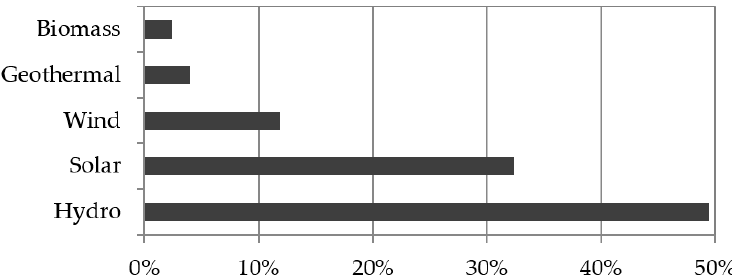
Figure 9. Breakdown of answers to the question “Which renewable energy sources, in your opinion, have the best growth potential in Bydgoszcz?” Source: own study.